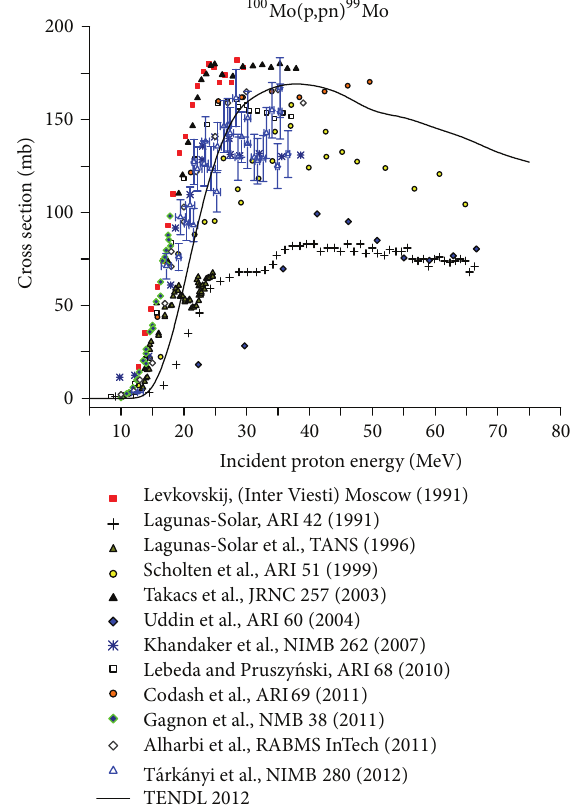
Figure 1: The collection of 100 Mo(p,pn) 99 Mo excitation functions experimentally measured in the last two decades. Error bars are shown for the most recent measurement only performed by T´ark´anyi (2012) [13]. The most recent theoretical excitation function by the TENDL 2012 library is also shown